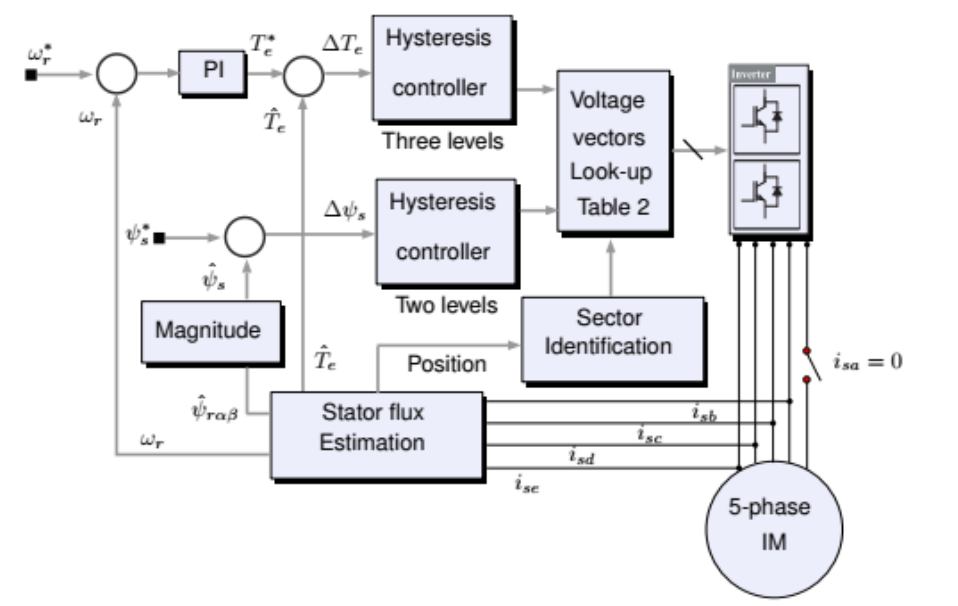
Figure 6. Implemented virtual voltages in the α – β plane using the designed post-fault DTC approach.